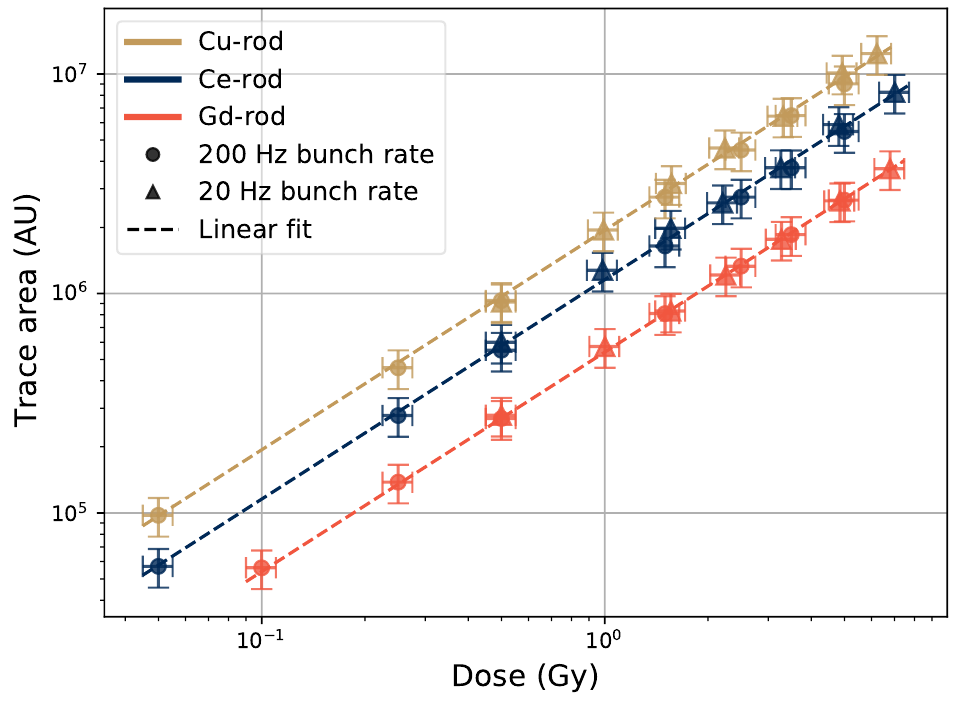
Figure 13. Total area of the recorded pulse traces as a function of run dose in the samples, from the same data sets as in Figures 7 and